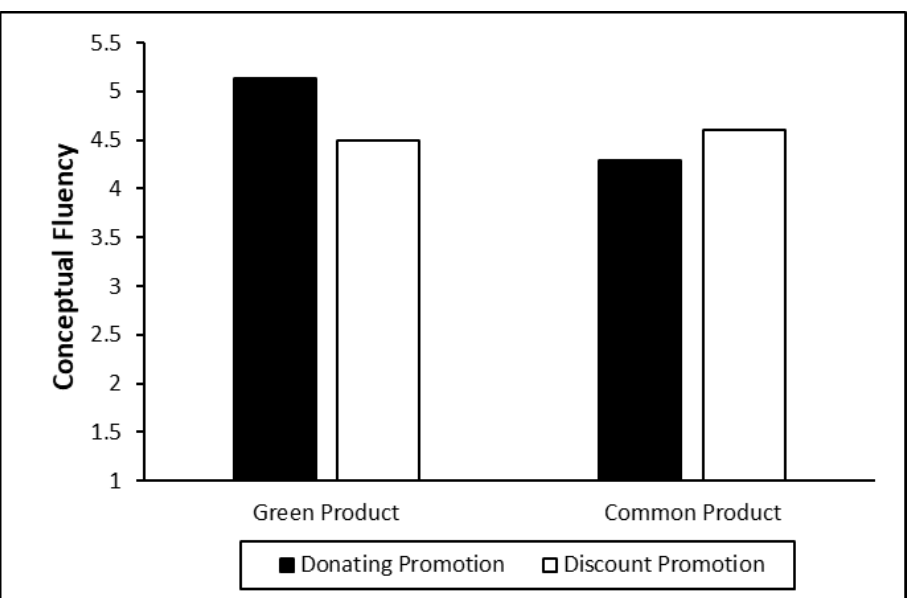
Figure 3. Conceptual fluency for green products vs. common products under different promotion modes.